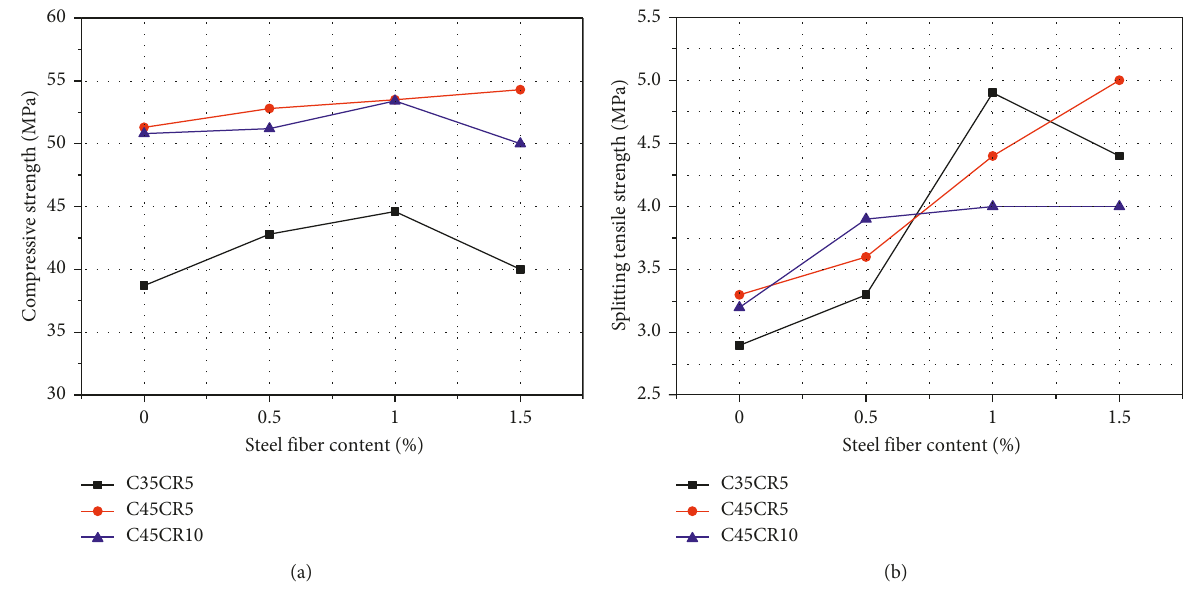
Figure 8: The effect of steel fibers on (a) compressive and (b) splitting tensile strengths.